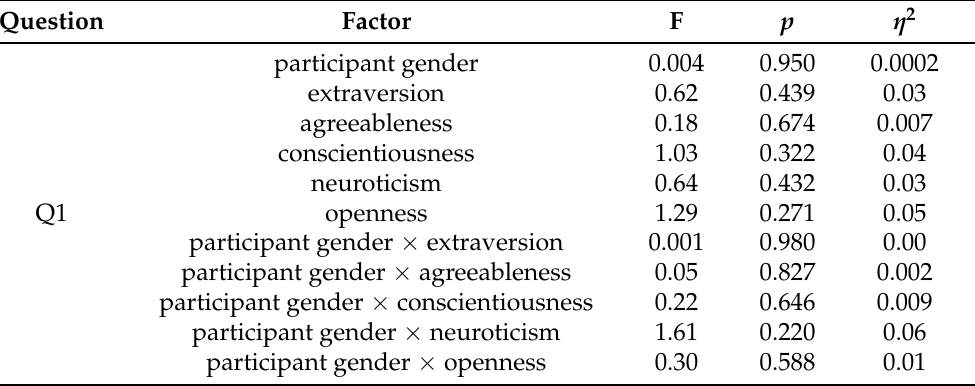
Table A1. GLM analysis of the effect of participants’ personality traits (i.e., extraversion, agreeable- ness, conscientiousness, neuroticism, openness) on their responses to question Q1.